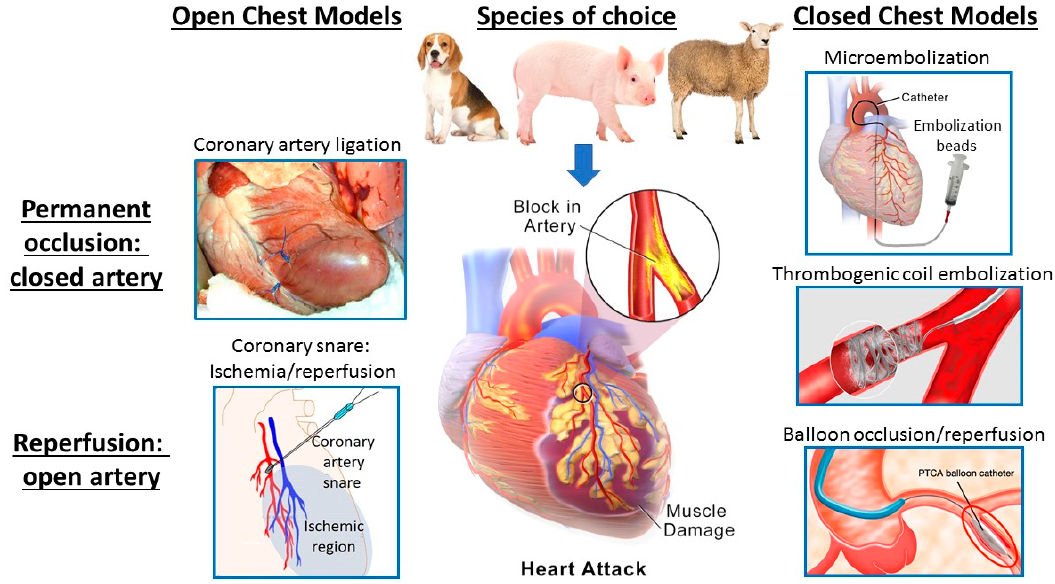
Figure 1. Variations of large animal models of acute myocardial ischemia / infarction showing species of choice and key variations in methodology ranging from open chest to closed chest and permanent occlusion to reperfused, open artery.